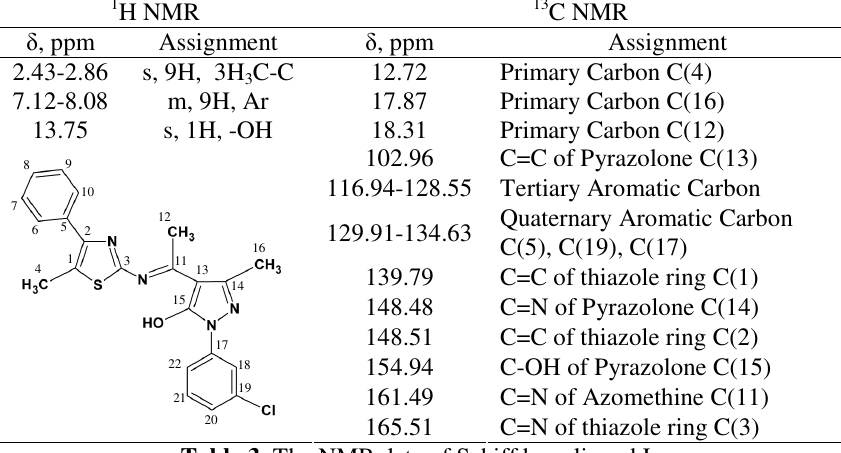
Table 2. The NMR data of Schiff base ligand L